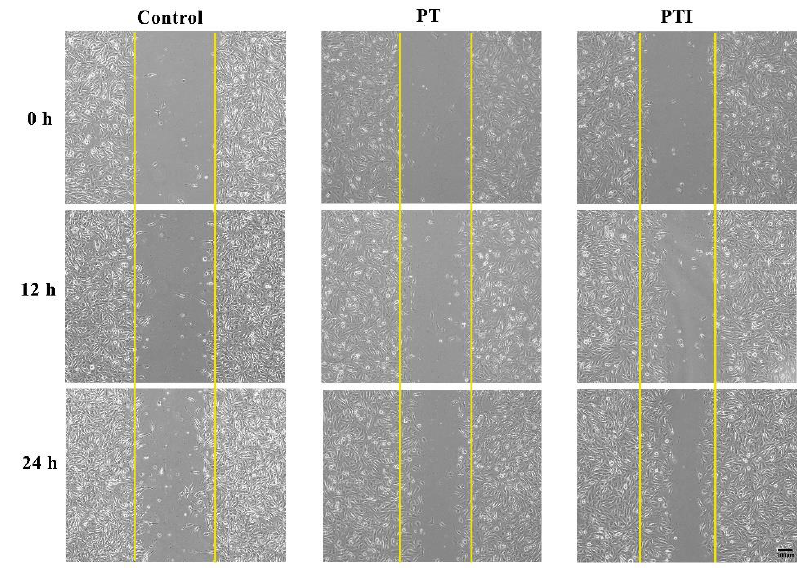
Figure 7. Scratch experiment to detect the effect of scaffolds’ leaching solution on the migration of EA.hy926 cells.